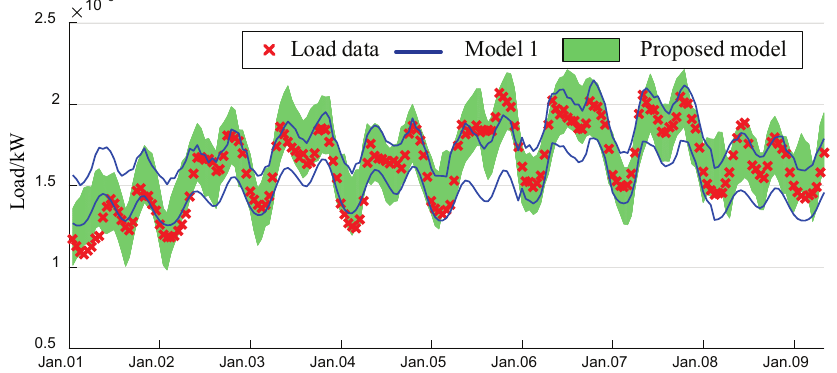
Figure 11. Accuracy under the same confidence level (A/CL) comparison between Model 1 and the proposed model under confidence level 50%.